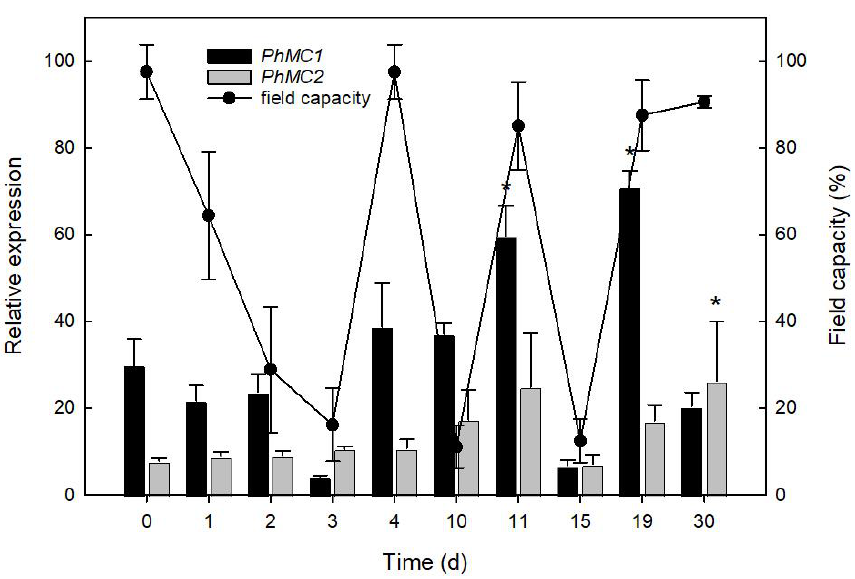
Figure 8. Metacaspase gene expression in petunia leaves during drought stress. Petunia × hybrida ‘Mitchell Diploid’ plants were grown in a growth chamber and water was withheld until plants showed visual signs of wilting. Twenty-four h after wilting was observed, plants were irrigated with clear water until plants recovered and regained turgidity. Water was then withheld from plants again and this cycle was repeated 3 times. After the final wilt-recovery cycle, plants were watered as needed for an additional 10 days. Leaf tissue was collected throughout the wilt-recovery cycles and relative mRNA abundance of PhMC1 and PhMC2 was analyzed by quantitative PCR (left axis). Transcripts are expressed relative to PhACTIN, and bars represent mean ± SD, n = 3. Asterisks (*) indicate a statistically significant difference between the expression level of the sample compared to the initial expression level (time = 0 days; p ≤ 0.05). Soil moisture content was measured throughout the wilt-recovery cycles and is expressed as the field capacity (right-axis). Mean field capacity is plotted (solid circles) and error bars represent SD ( n =